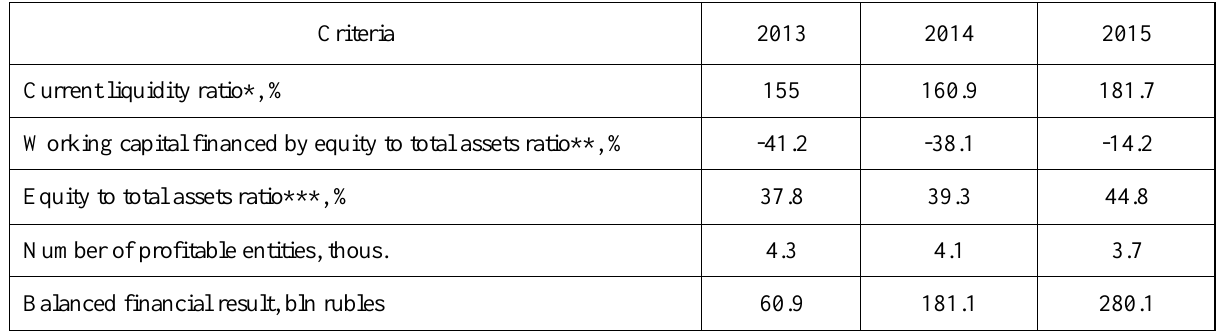
Table 3 . Some parameters characterizing the financial standing and financial performance of agricultural entities for